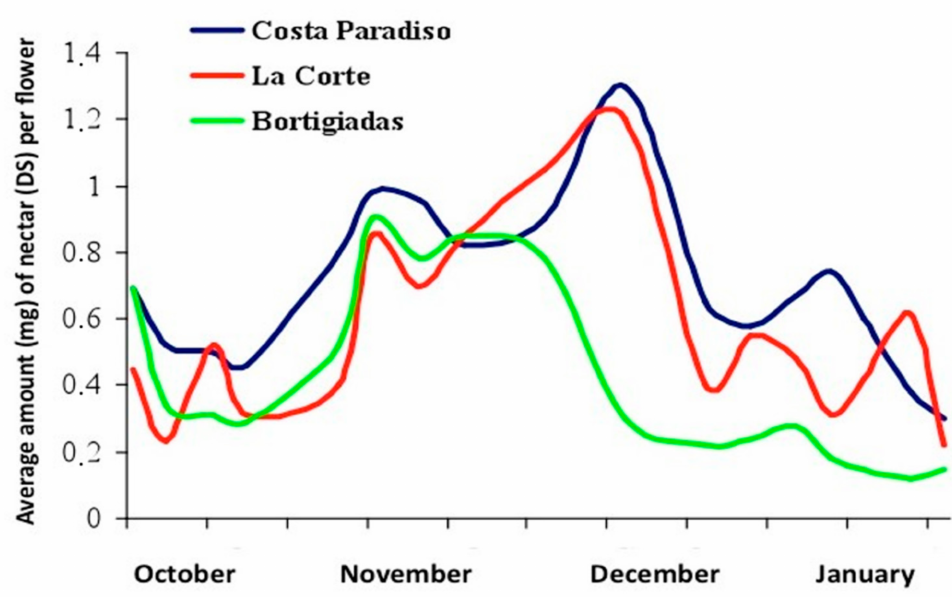
Figure 2. Trends in nectar secretion of strawberry tree ( Arbutus unedo L.) flower in different locations of northern Sardinia